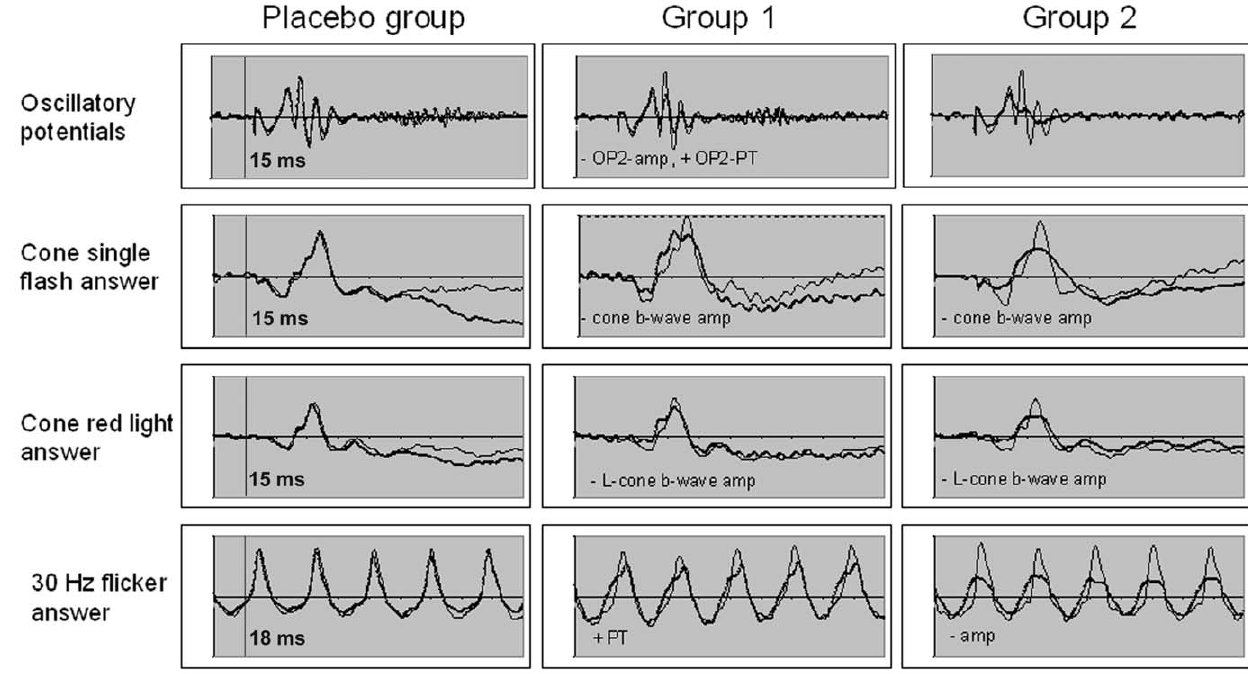
Figure 5. Mean cone-ERG. Recordings of each group for baseline (thin line) and 4 hours after treatment (thick line). An almost dose-dependent amplitude decrease can be seen in all cone-ERG modalities. Significant increments ( + ) and decrements ( 2 ) of the deflections as compared to baseline are marked in the according graphs (PT=peak time, amp=amplitude).